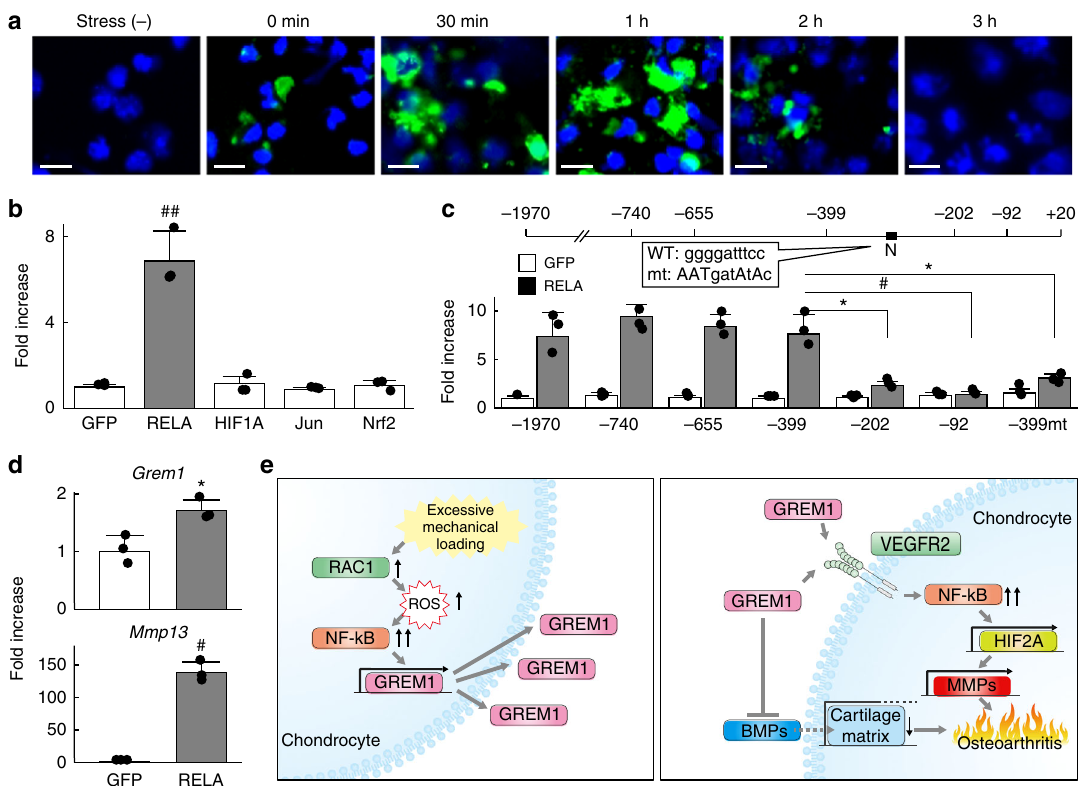
Fig. 8 The ROS- NF- κ B pathway enhances transcriptional induction of gremlin-1. a Fluorescence imaging time-course of ROS production in mouse primary chondrocytes after cyclic tensile strain loading. Nuclei were stained with DAPI (blue). Scale bars, 20 µ m. b Luciferase assay using ATDC5 cells co-transfected with human GREM1 promoter (from − 1970 to + 20 bp relative to the transcriptional start site) and each expression vector. ## P < 0.001 versus GFP (one-way ANOVA test). c 5 ʹ -deletion and mutation analyses of the luciferase assay. N: NF- κ B motif, − 399mt: reporter construct from − 399 to + 20 bp in which NF- κ B motif is mutated. * P < 0.05, # P < 0.005 (Student ’ s unpaired two-tailed t -test). d mRNA levels of Gremlin-1 and Mmp13 in